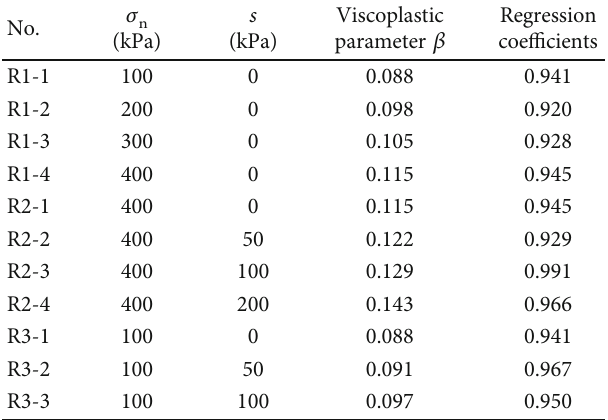
Table 3: Viscoplastic parameter β values under di ff erent test